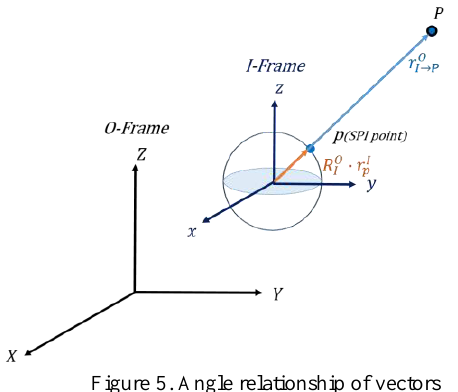
Figure 5. Angle relationship of vectors